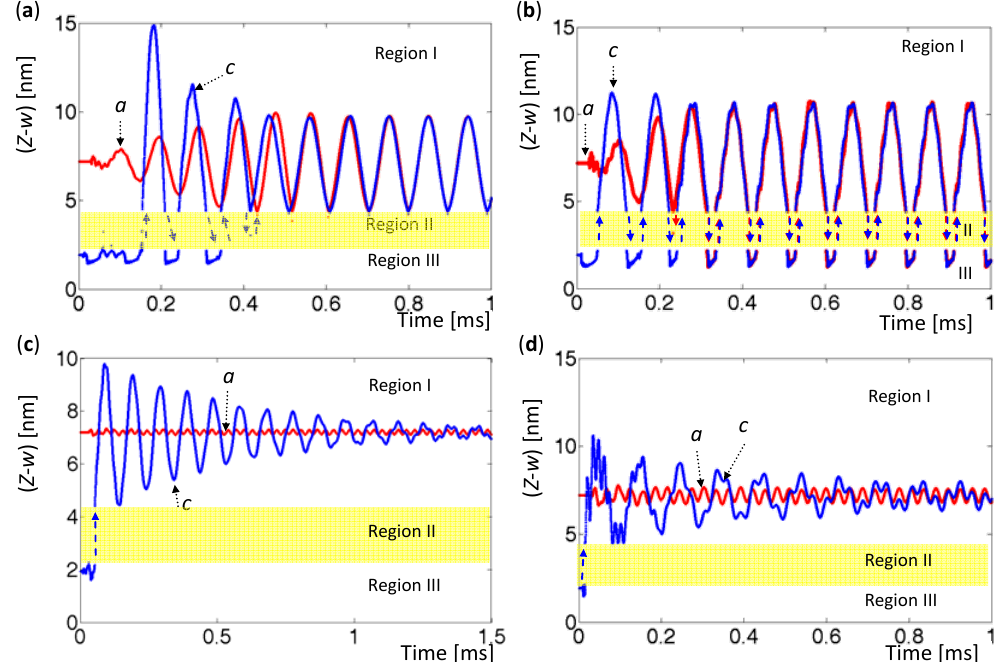
Figure 10. Time histories associated with phase portraits in Figures 8( c ), 8( d ), 9( b ),